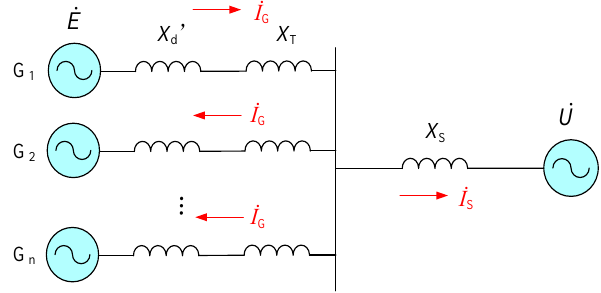
Figure 7. Schematic diagram of the single generator out-of-step condition.